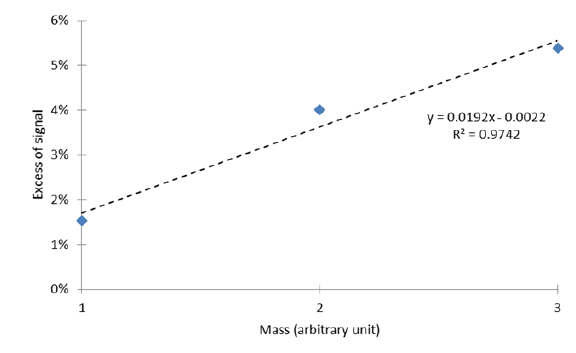
Fig. 15. Experimental results obtained for various masses of